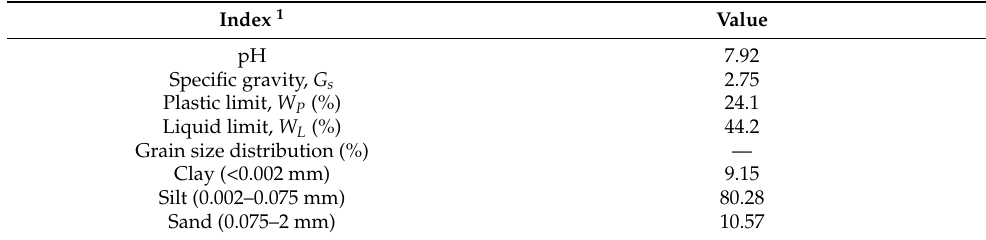
Table 1. Characteristic indexes of the tested soil.